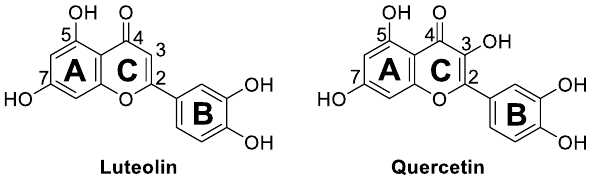
Figure 1. Chemical structures of luteolin and quercetin.